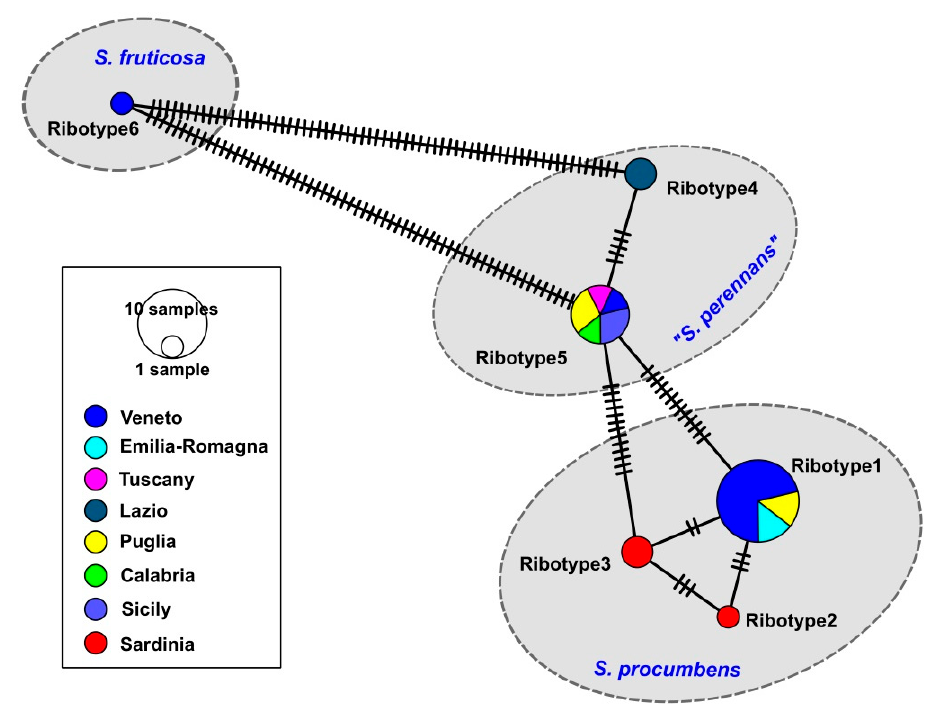
Figure 4. Minimum Spanning Network obtained with the program PopART of the ETS ribotypes found in Italy for the genus Salicornia .